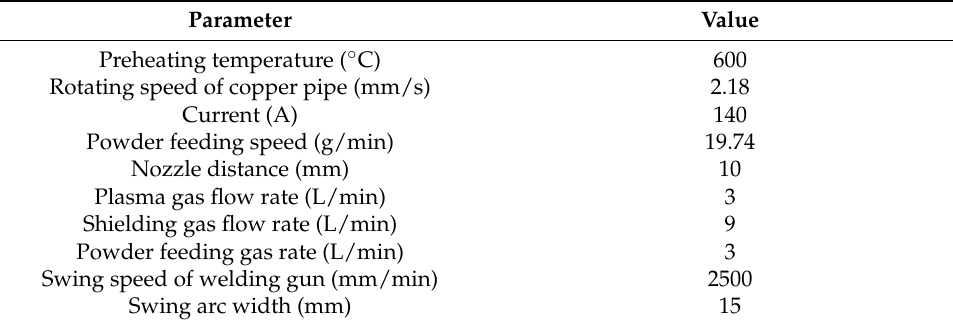
Table 2. Cladding parameters of swing arc cladding.